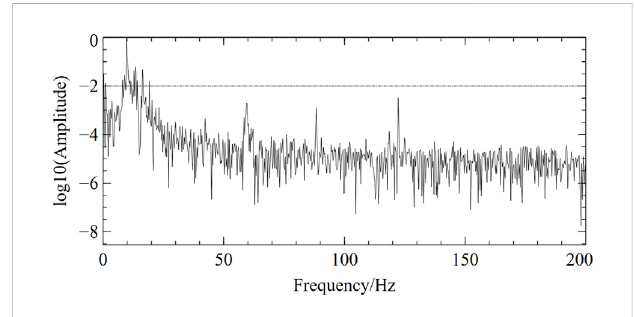
FIGURE 5 Spectrum of beam-pointing fl uctuations in the SGII-UP- Petawatt – picosecond system.